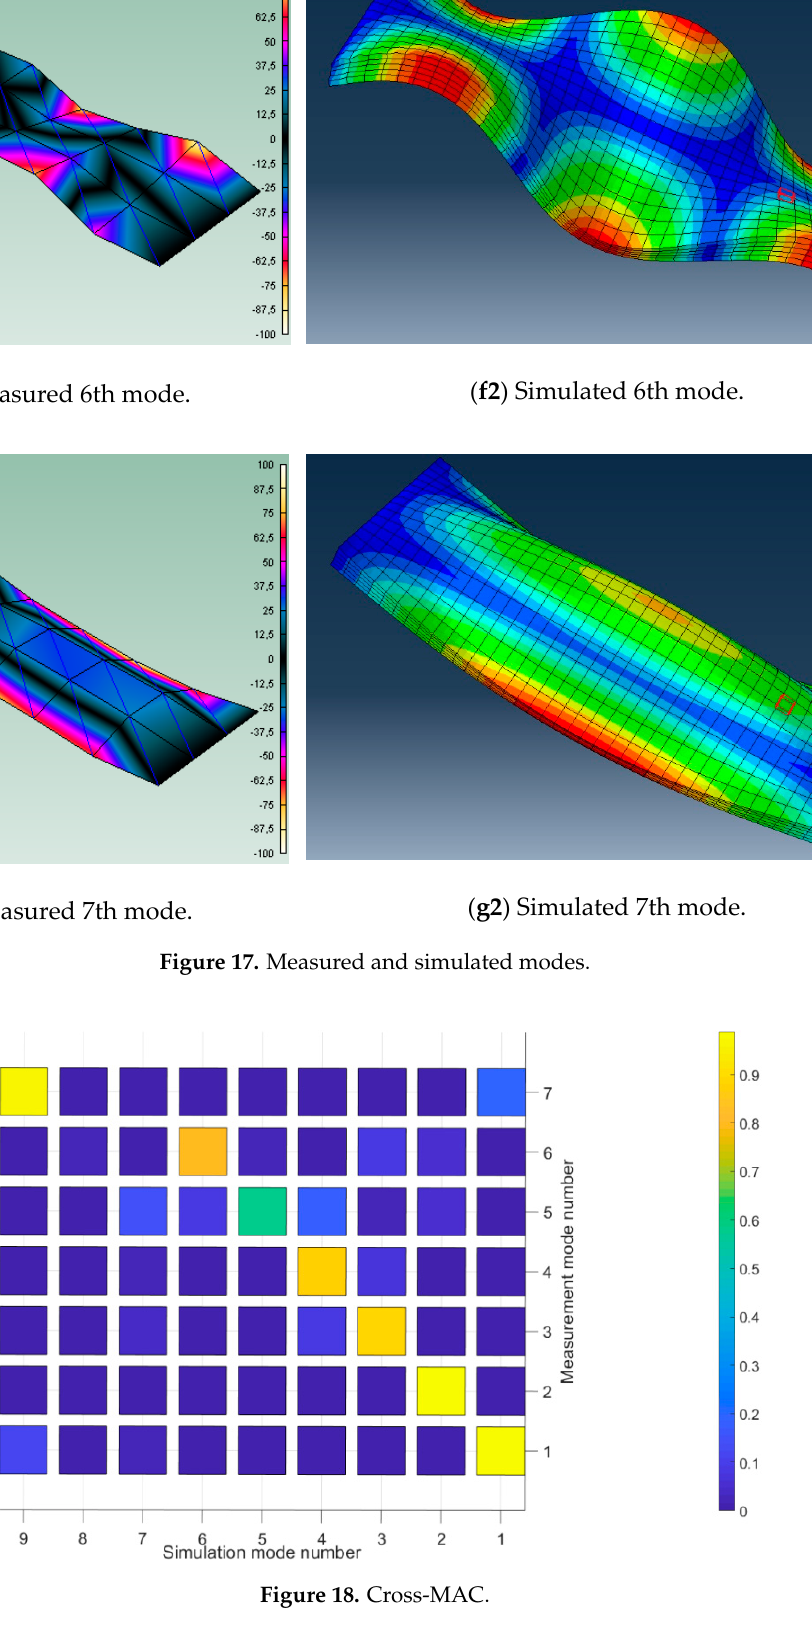
Figure 18. Figure 17. Cross-MAC. Figure 17. Cross-MAC.